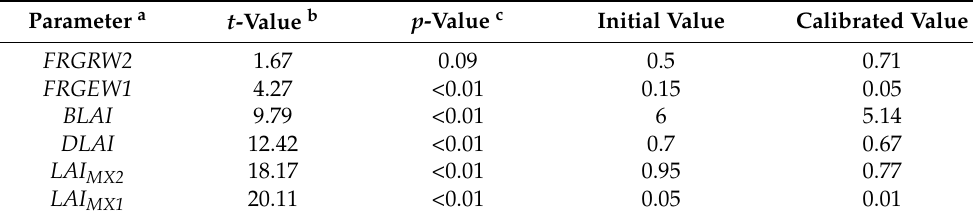
Table 5. Global sensitivities of the parameters that affect the leaf area index.